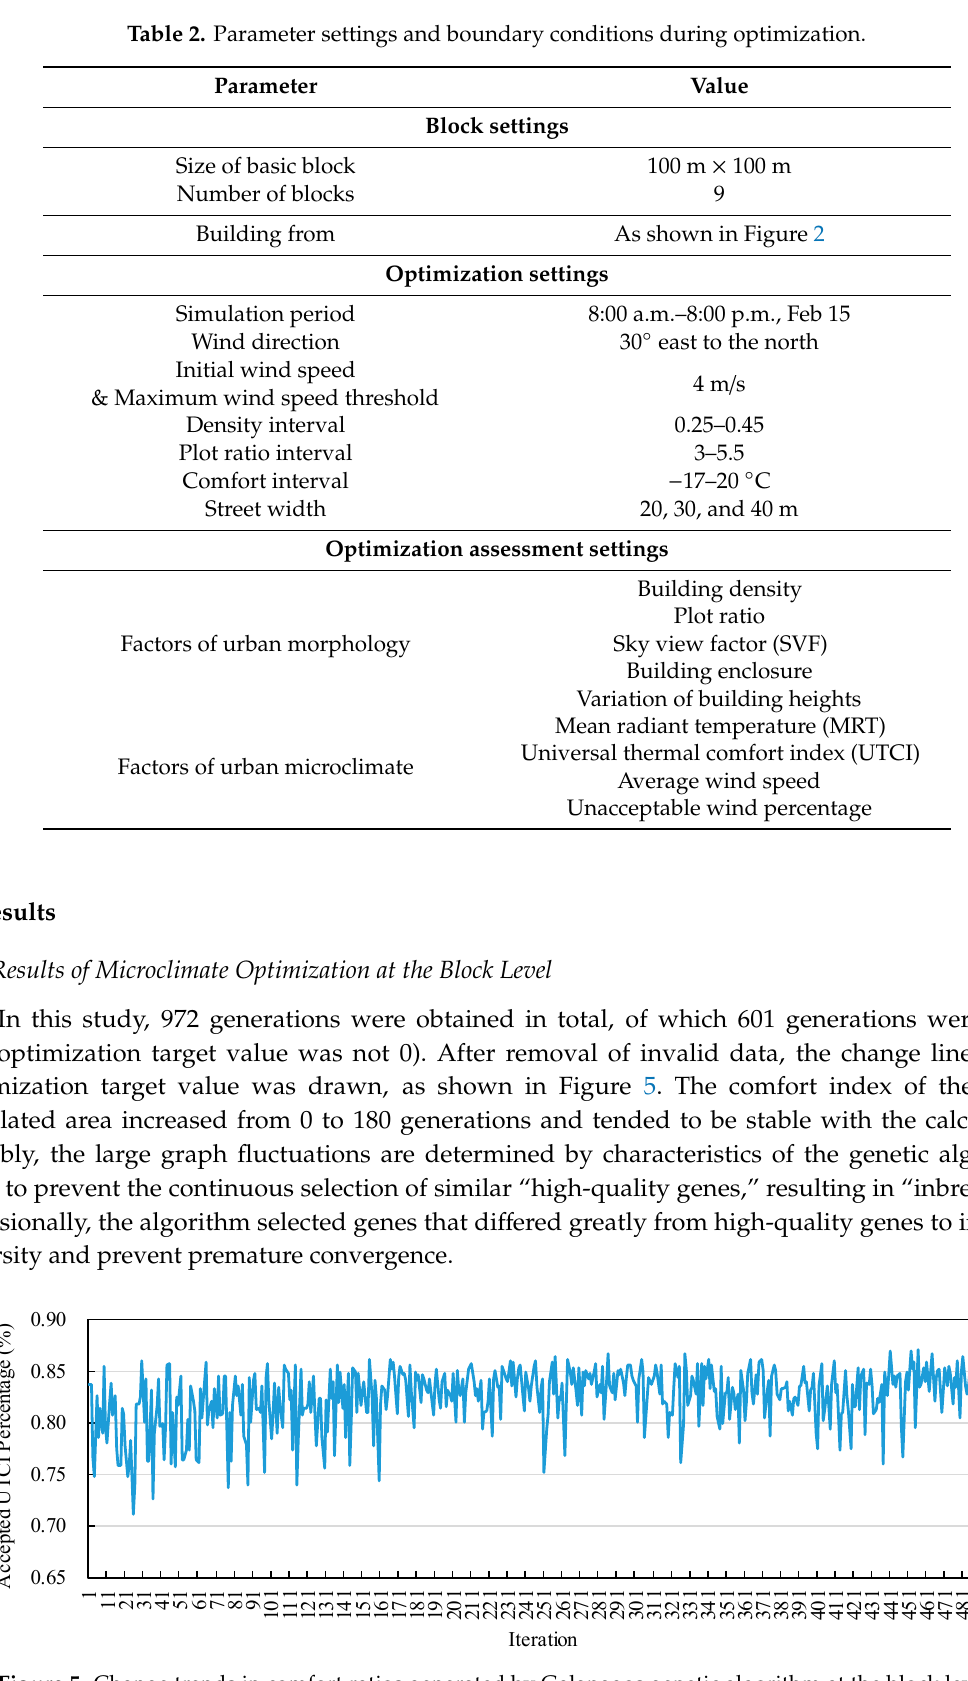
Figure 5. Change trends in comfort ratios generated by Galapagos genetic algorithm at the block